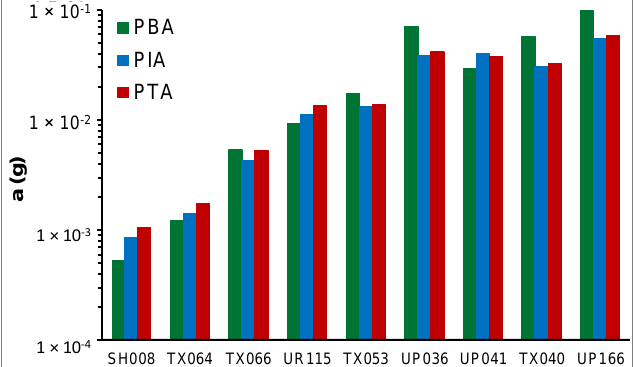
Figure 14. Maximum absolute acceleration at the basement PBA (A01 and A03 in x and y direction, respectively), above the isolation system PIA (A04 and A05), and at the top of the building PTA (A10 and A11), for all the recorded seismic events.